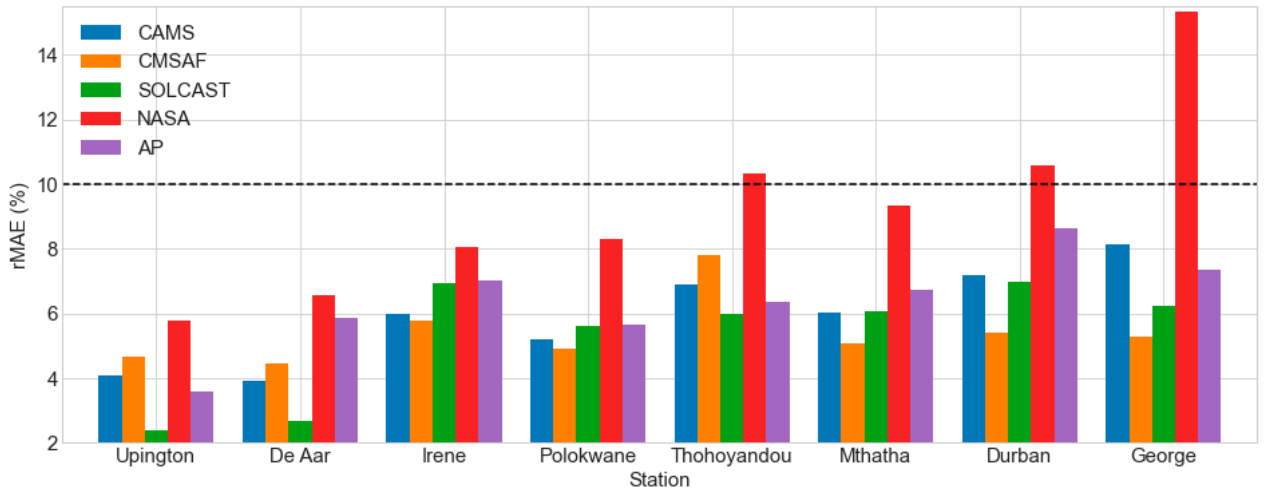
Figure 4. The daily rRMSE of the derived GHI datasets under all-sky conditions.